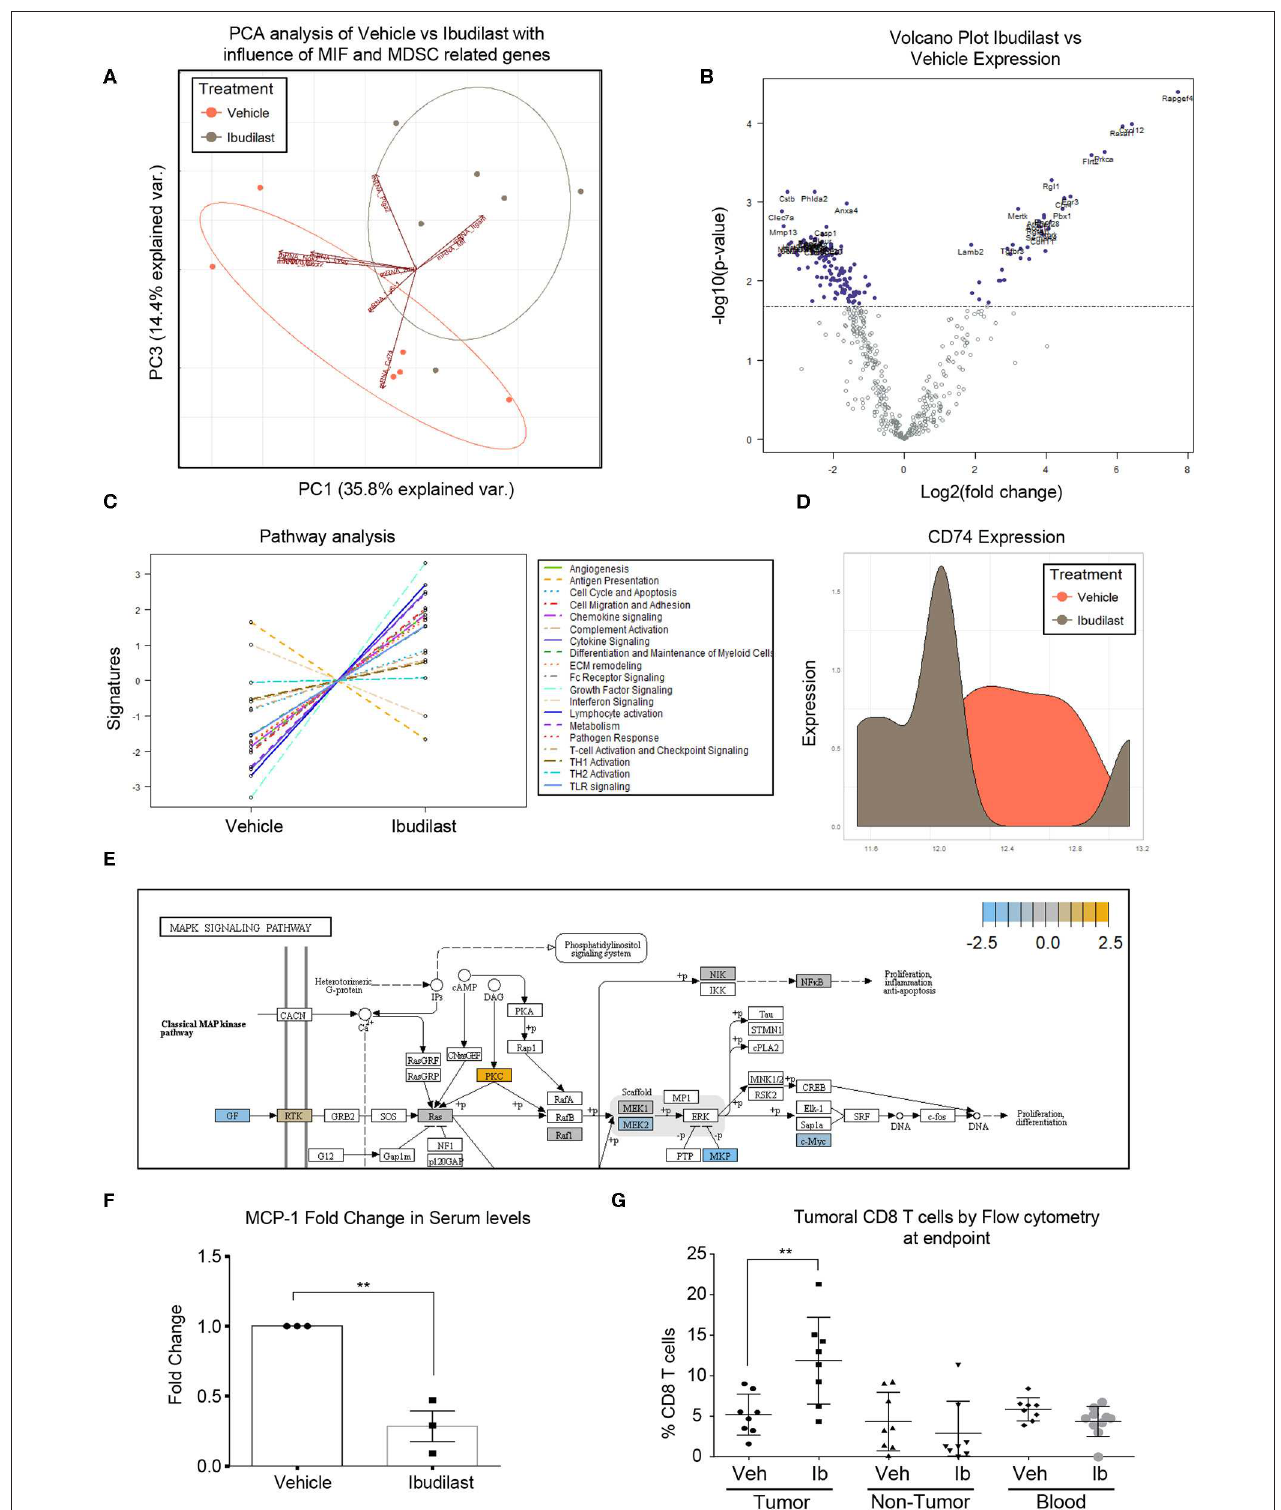
FIGURE 5 | Ibudilast inhibits the MIF disrupting M-MDSC generation in vitro. n = 6 vehicle and n = 6 Ibudilast treated mice (50 mg/kg 2x weekly starting day 5 post tumor implantation) were sacrificed at endpoint and tumors were dissected from the brain for RNA isolation. RNA from isolated tumors of vehicle and ibudilast